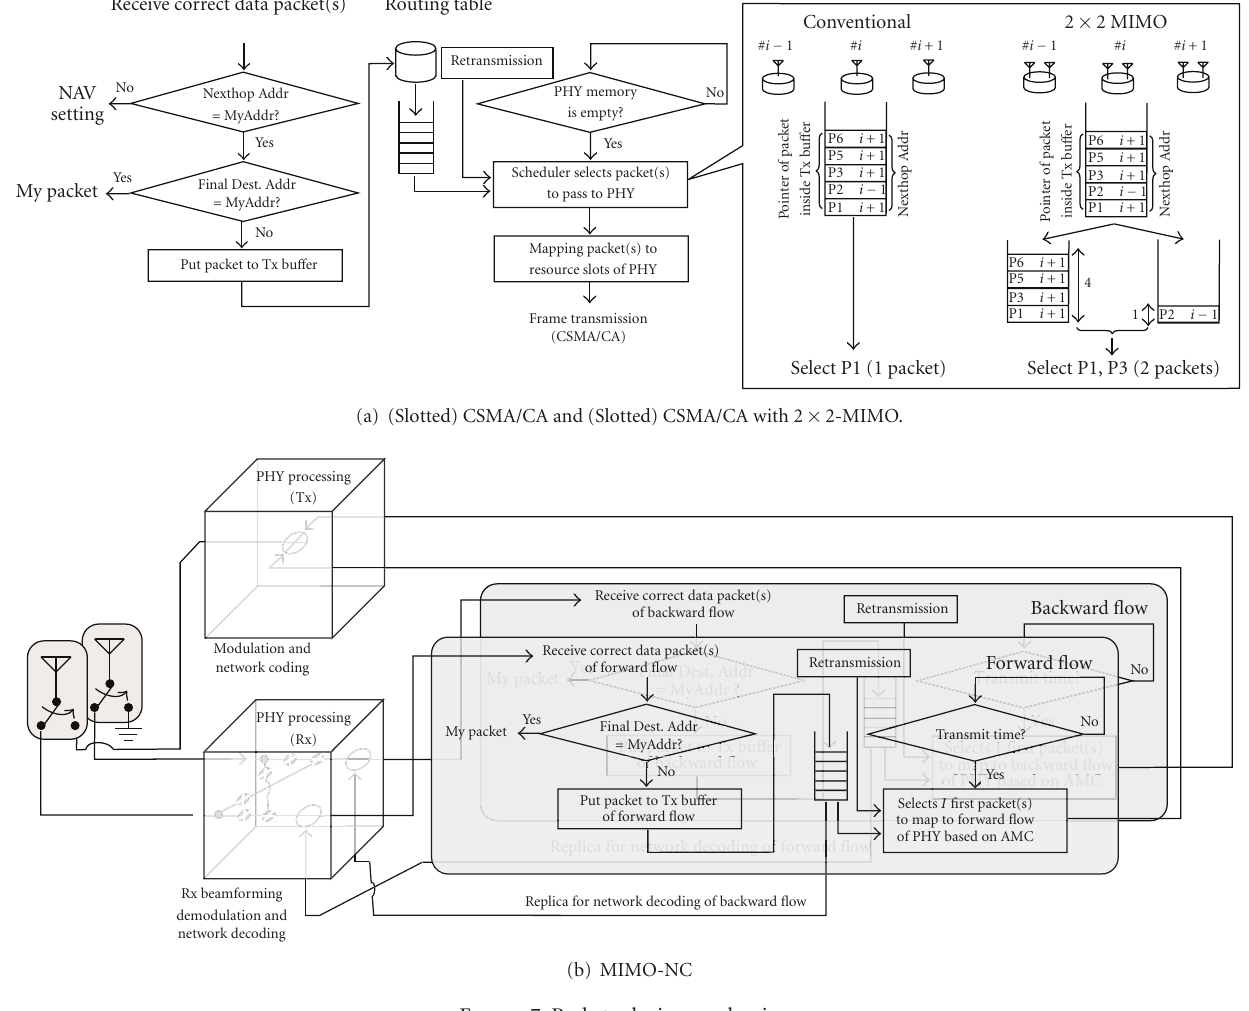
Figure 8. Since link adaptation is employed in MIMO- NC, bu ff ers are implemented to store packets. The frame contains a network coding header, necessary for network decoding, followed by the network coded signals. Based on the channel conditions, di ff erent number of packets are selected to be relayed in forward and backward directions, that is, I and J , respectively, in the example. Packets of